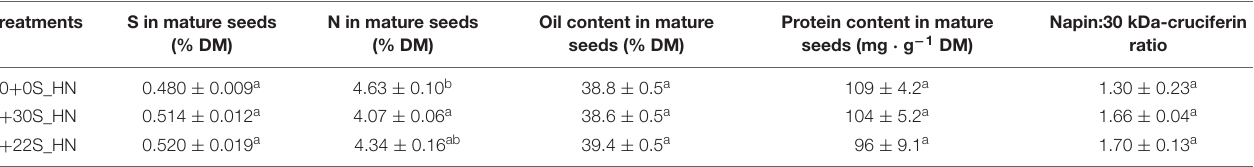
The values correspond to the mean ± SE (n = 5, n = 4 for napin/cruciferin ratio for 30 + 0S_HN). Different letters indicate that mean values are significantly different (p < 0.05).